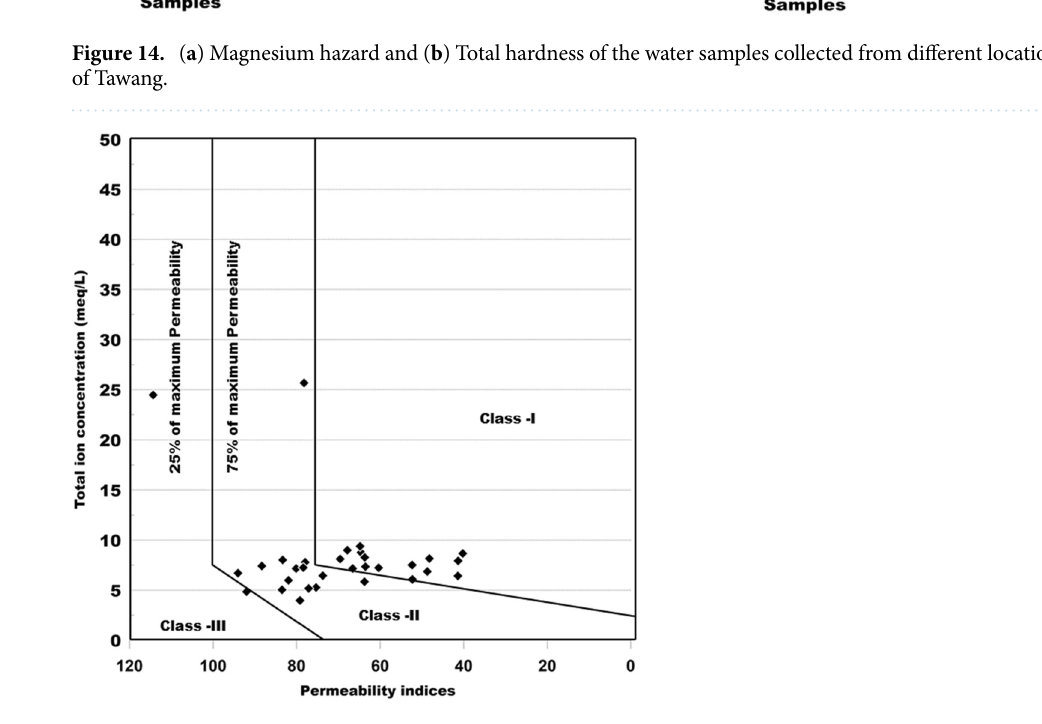
Figure 15. Irrigation water classification based on Permeability